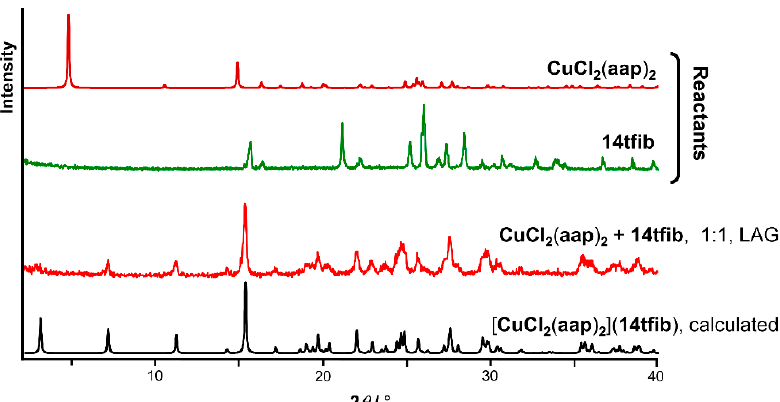
Figure 2. A comparison of the powder X-ray diffraction patterns of the reactants, the LAG product, and the pattern calculated from the [CuCl 2 ( aap ) 2 ]( 14tfib ) single crystal X-ray diffraction data.